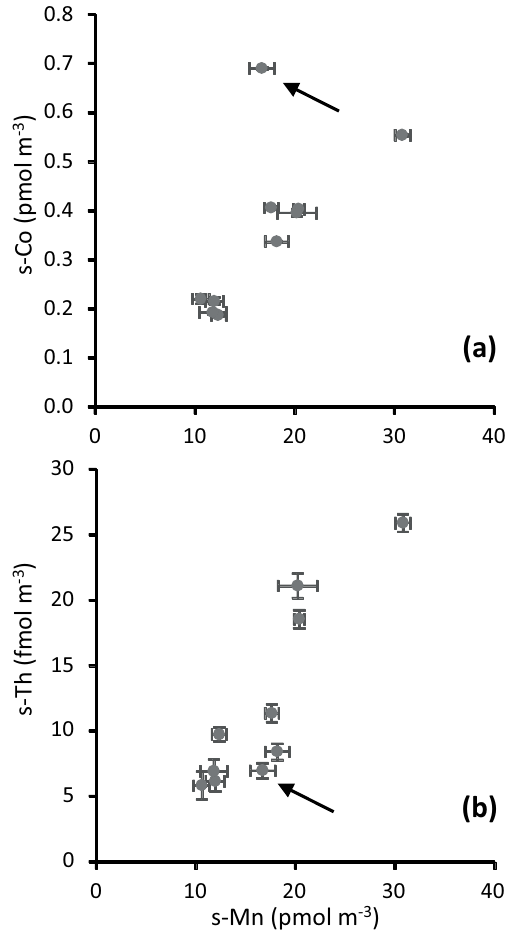
Figure 4. Plots of (a) soluble cobalt (s-Co) and (b) soluble tho- rium (s-Th) against soluble manganese (s-Mn) concentrations in M91 aerosol samples. Sample TM09 is indicated by an arrow in both